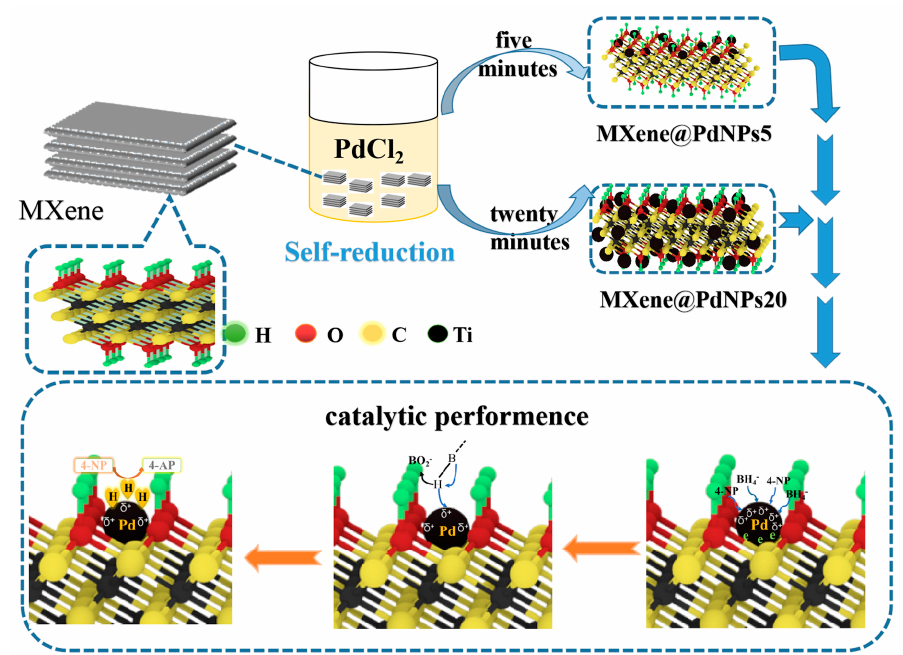
Figure 1. Schematic illustration of preparation and catalytic application of PMXene@PdNPs materials.